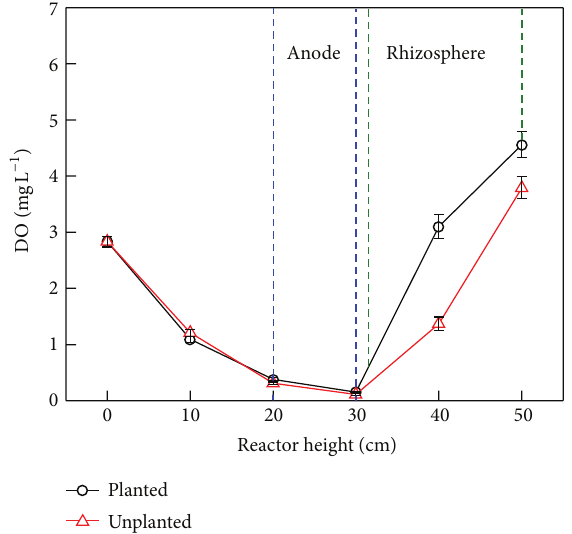
Figure 5: The change of DO in the planted CW-MFC and unplanted